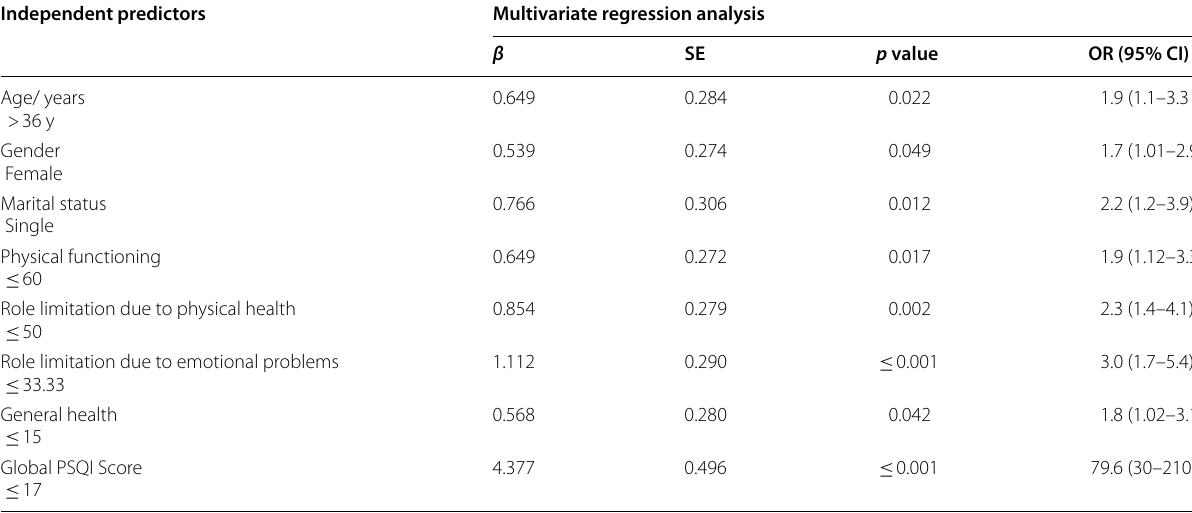
Continues variables were divided according to median value SE standard error, OR odds ratio, CI confidence interval, PSQI Pittsburgh sleep quality index